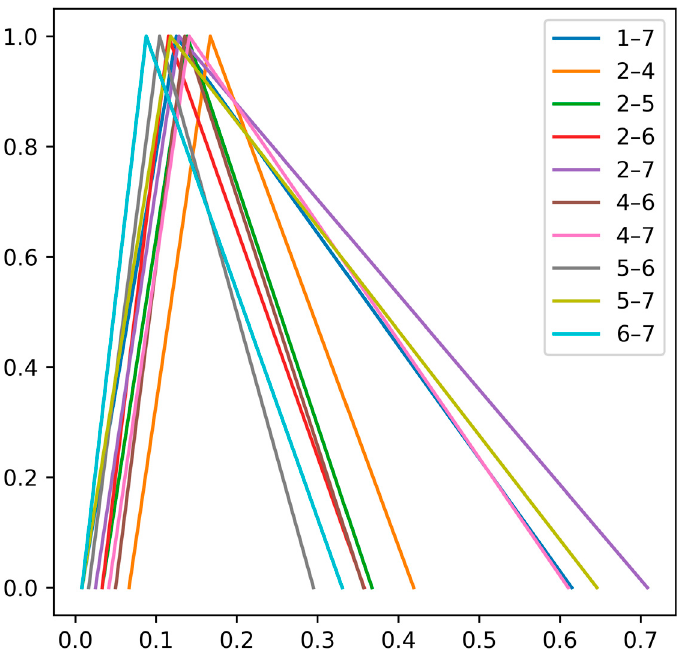
Figure 3. Final route scores.